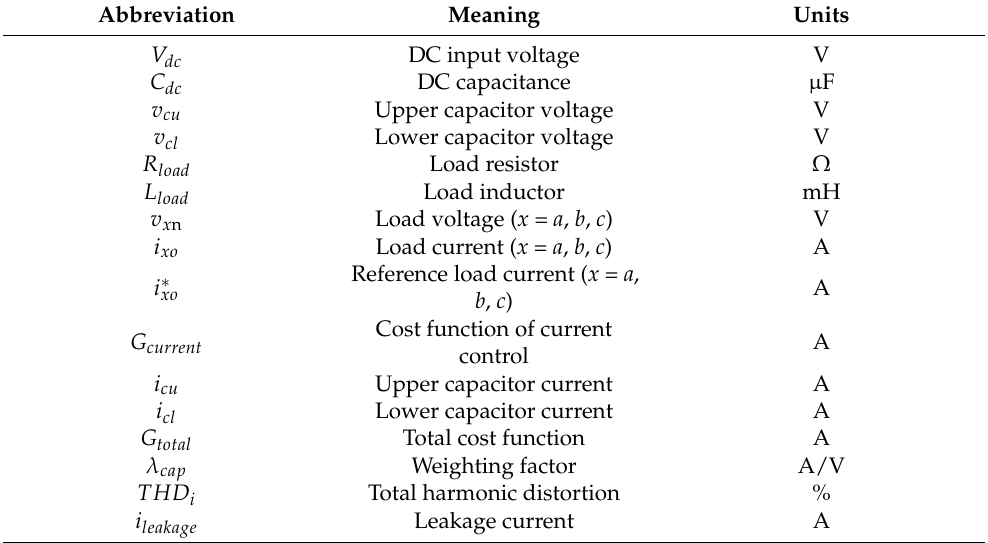
Table 7. Common abbreviations that do not need defining in the